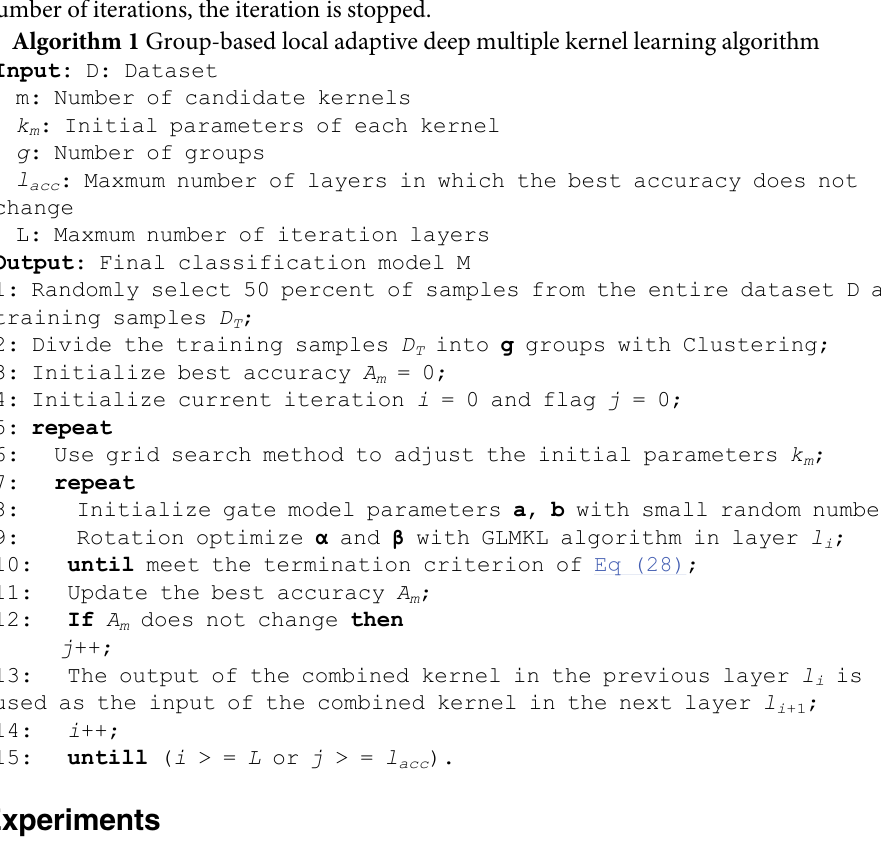
Algorithm 1 Group-based local adaptive deep multiple kernel learning